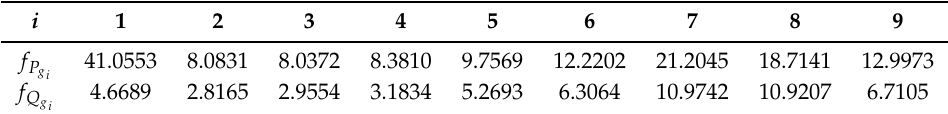
Table 5. Minimum values of the 18 performance indices achievable by the six-parameter controllers of design concept 1.